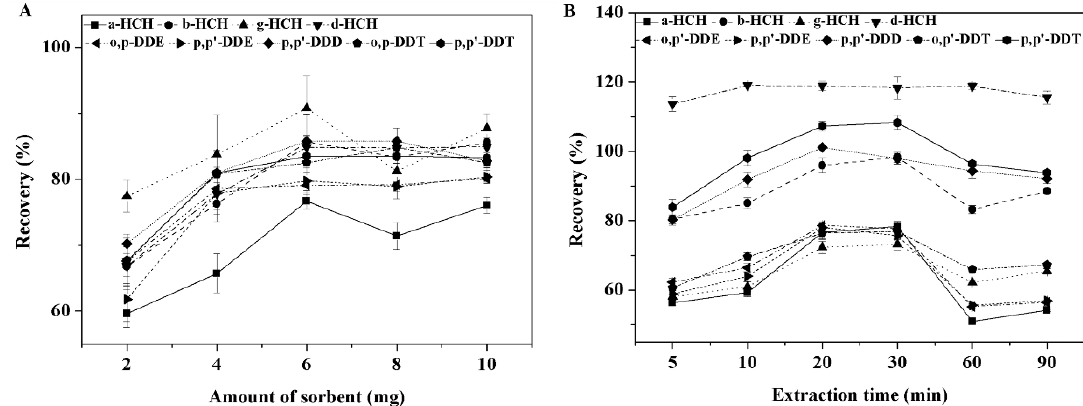
Figure 4. Optimization of the extraction process for 50 µg L −1 organochlorine pesticides using zeolitic imidazolate framework based on magnetic multiwalled carbon nanotubes: ( A ) amount of sorbent and ( B ) extraction time. Desorption conditions: 2 mL of acetonitrile; ultrasonication time, 5 min; and ultrasonication performed one more time. The error bars show the standard deviation of the mean ( n = 3).